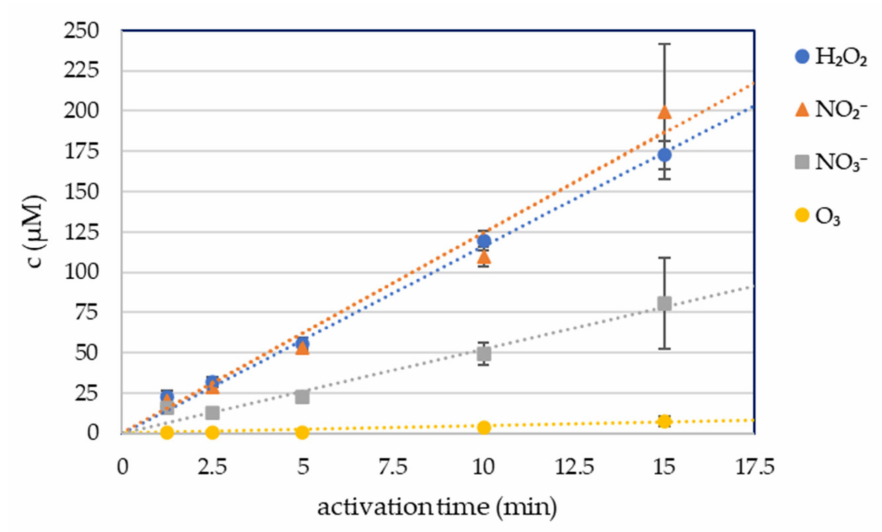
Figure 1. Hydrogen peroxide, nitrite, nitrate and ozone concentration in plasma-activated PBS